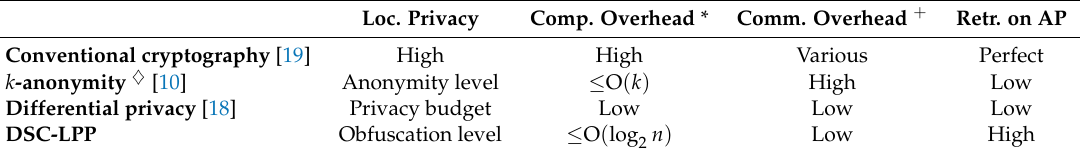
Table 2. Comparison of different LPP